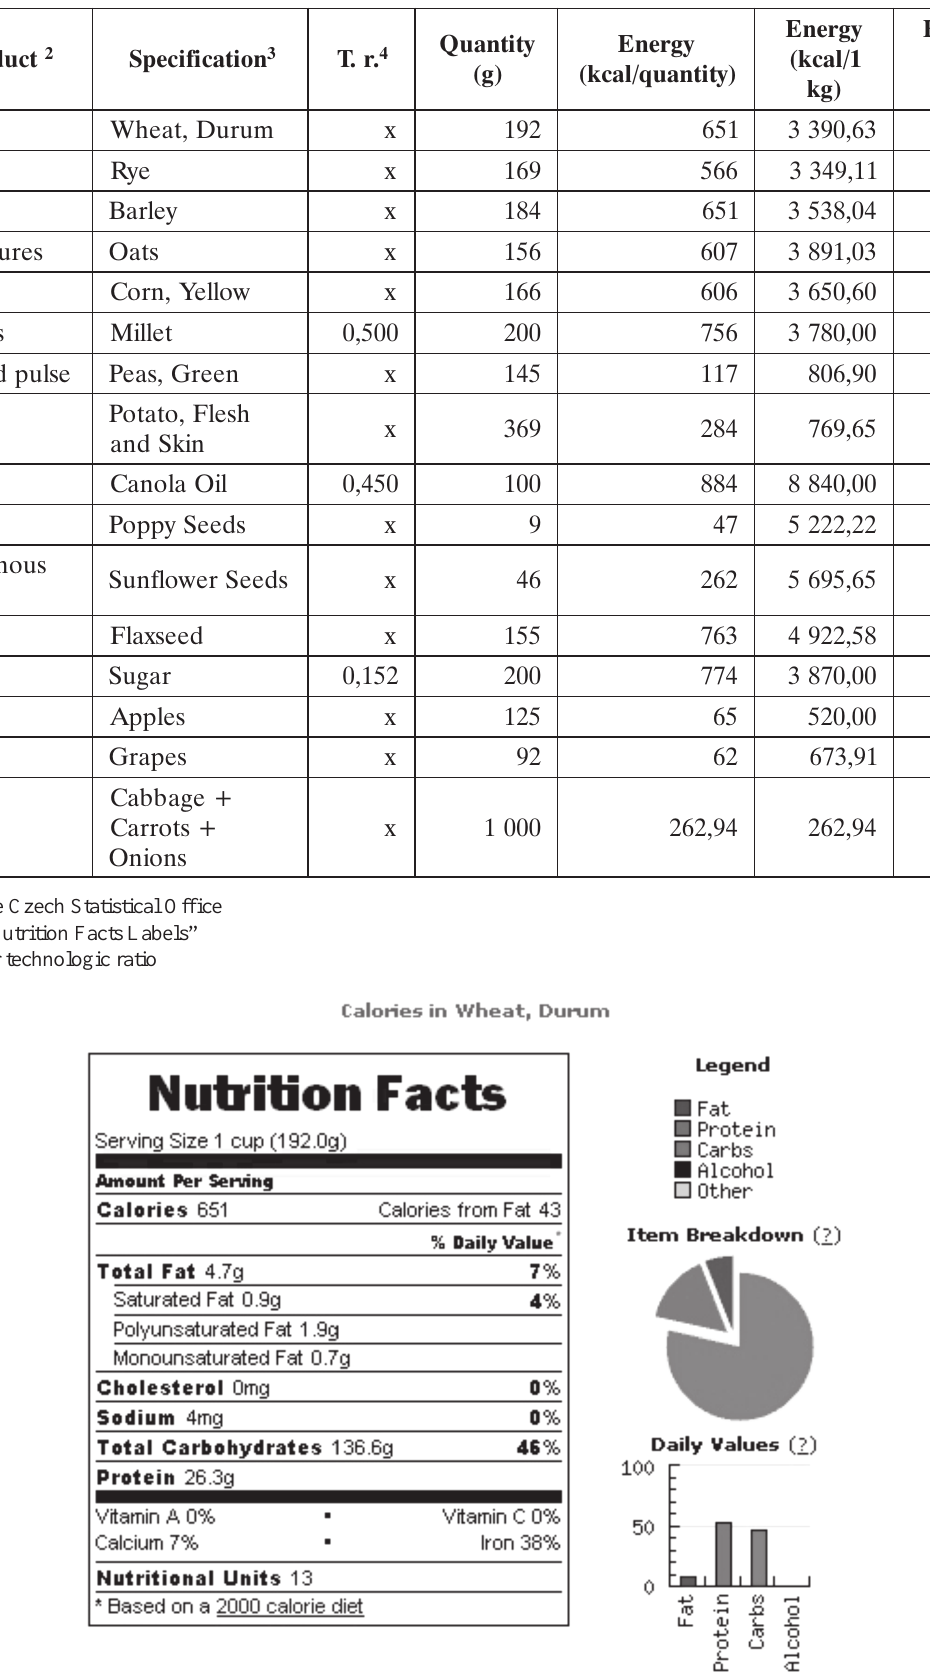
Fig 1. Calories in wheat, durum [6,